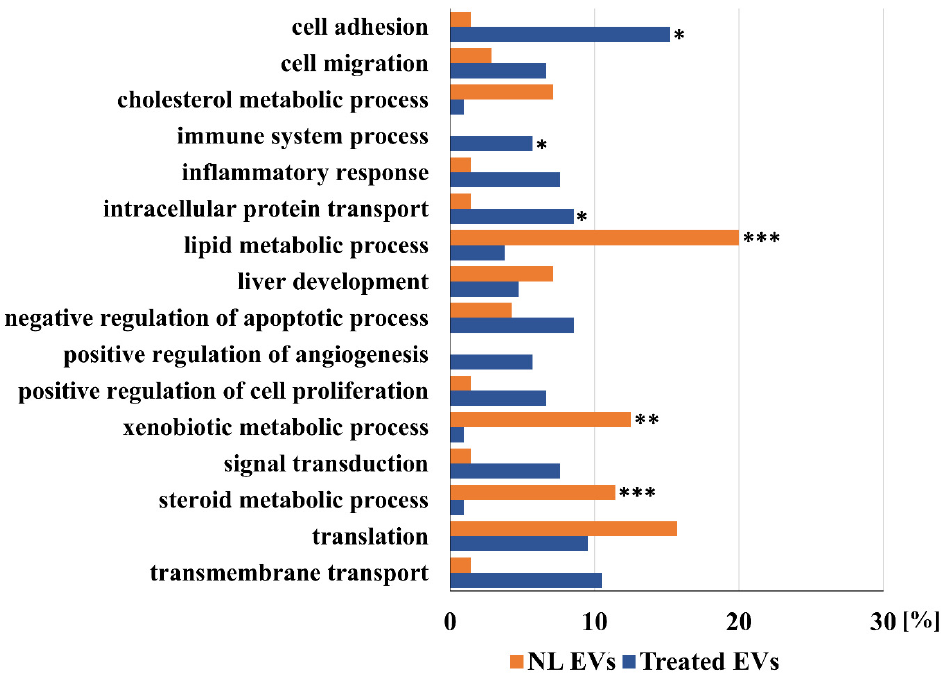
Figure 3. Comparison of unique proteins of normal (NL EVs) and acetaminophen treated (Treated EVs) liver EVs annotated according to their biological process. For the enrichment of GO terms the threshold was set at the p < 0.001. Statistically significant enriched GO terms are marked according to the obtained p -value: * p < 0.001, ** p < 0.0001, *** p < 0.00001. Table 1. List of proteins detected in EVs shed by normal (nontreated) liver according to their cellular origin.